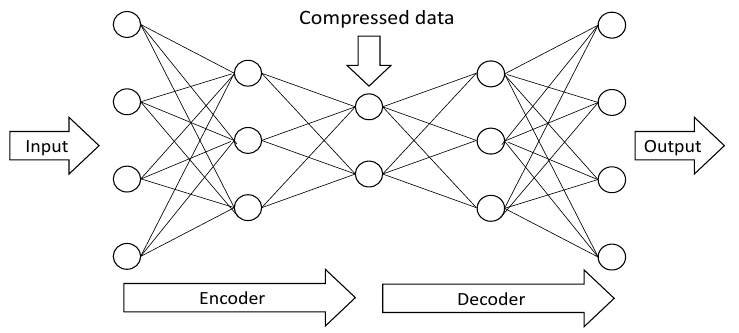
Figure 4. Autoencoder structure.